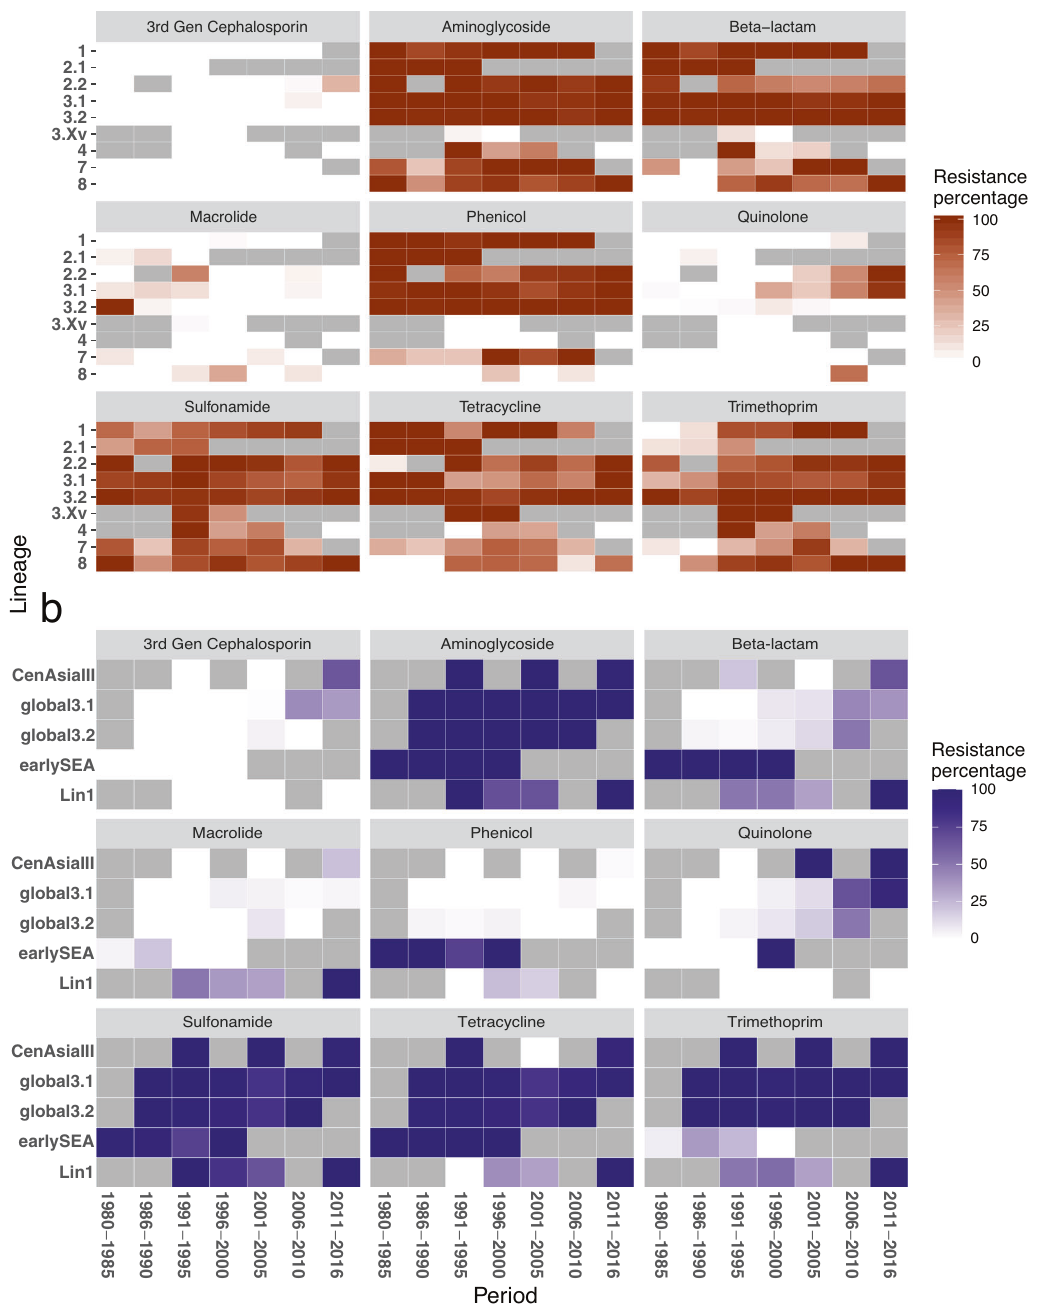
Fig. 3 Trend of antimicrobial resistance (AMR) genotype in Southeast Asian Shigella fl exneri and Shigella sonnei . a Trend of AMR genotype in 990 Southeast Asian Shigella fl exneri and ( b ) 880 Southeast Asian Shigella sonnei . Each heatmap plot details the resistance trend against a class of antimicrobial, as identi fi ed by presence of AMR genetic determinants (see Methods) and categorised into different phylogenetic lineages. The cell ’ s colour intensity positively correlates to the proportion of sequenced isolates, belonging to a particular lineage during a de fi ned duration, encoding resistance to the examined antimicrobial class (see key). The grey cells denote the absence of sequenced